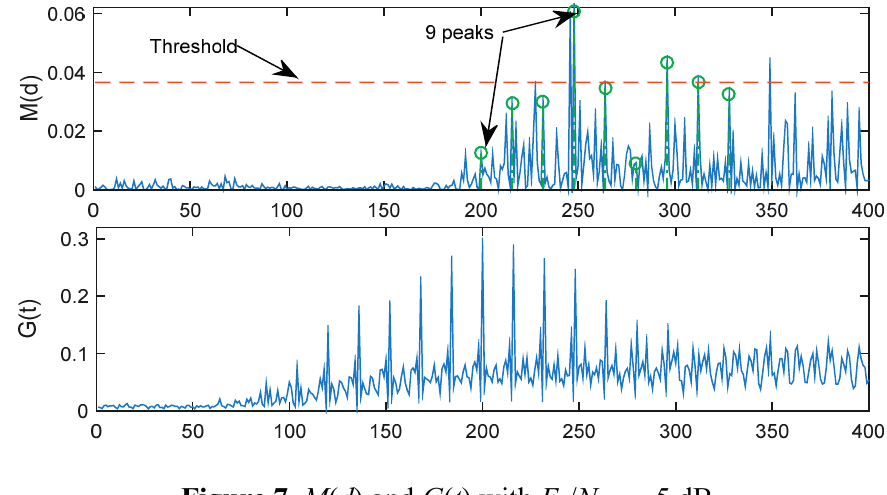
Figure 7. M ( d ) and G ( t ) with E b / N 0 = − 5 dB.